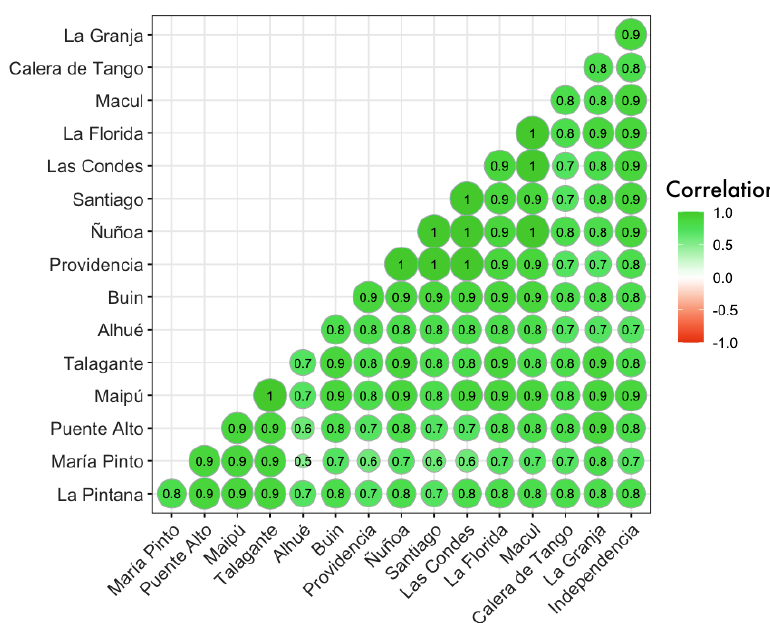
Figure 7. Representation of the correlations between the daily values of the mobility indices for the communes of the Metropolitan Region. A high positive correlation is observed in the mobility of all the